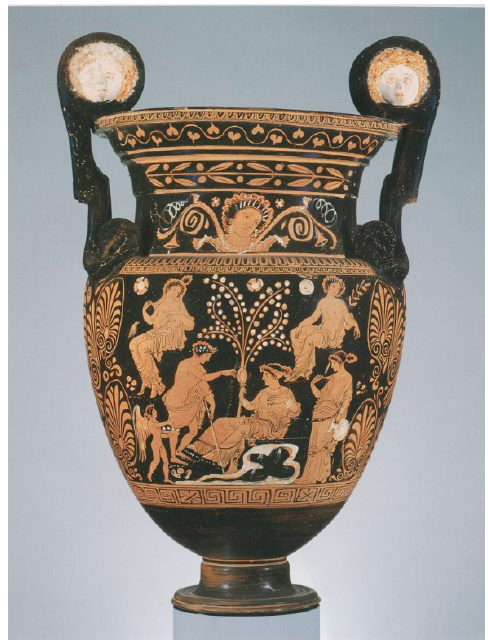
Figure 2. Boston, Museum of Fine Arts 1970.235 Apulian volute-krater, Iliupersis Painter, ca. 365–355 B.C. Female head in floral surround (neck), group of two youths and three women assembled in a garden in the presence of Eros (body). Photograph © Museum of Fine Arts, Boston.